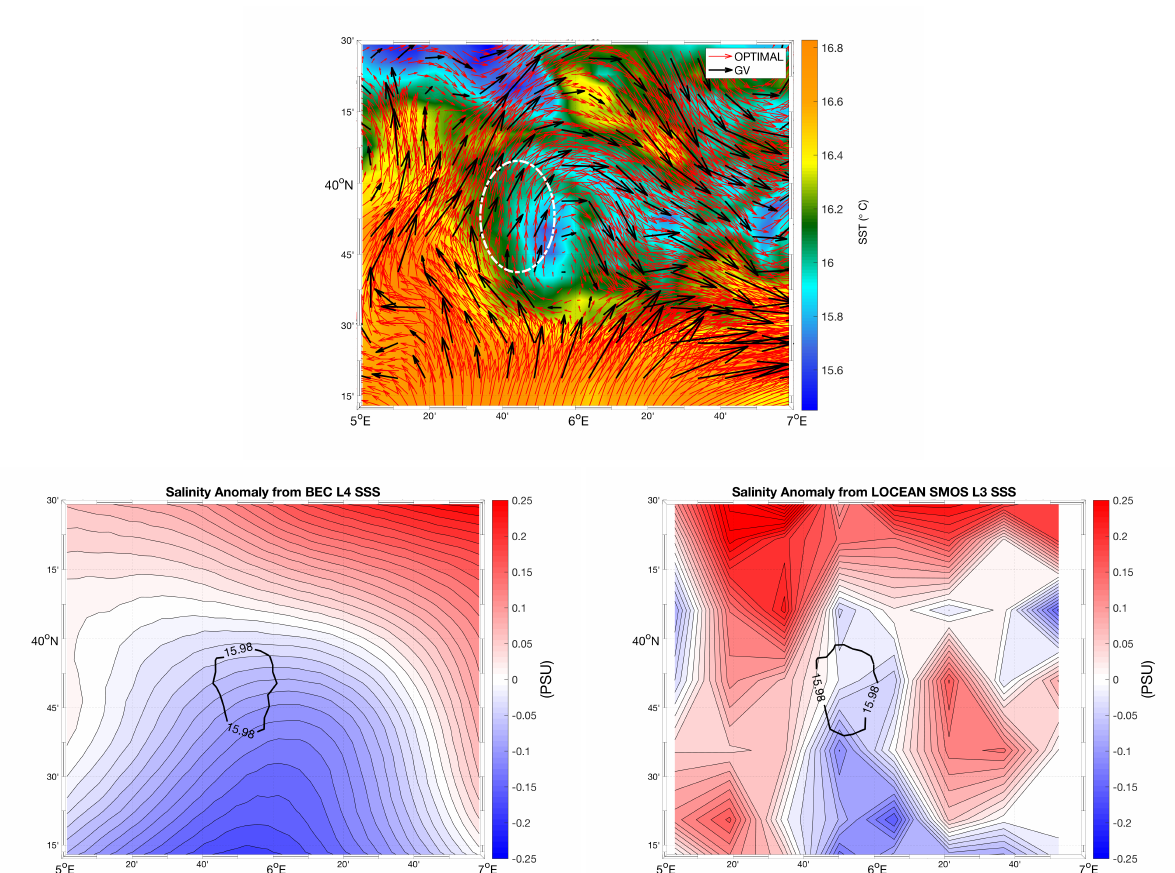
Figure 4. Top: Comparison between the Optimal currents (red arrows) and the GV (black arrows) in presence of anticyclonic circulation in the Western Mediterranean (25th of April 2016). The surface currents fields are superimposed to the SST (in colours, ◦ C); the white ellipse is referenced in Section 4.1. Bottom left: Soil moisture and ocean salinity (SMOS)-derived sea-surface salinity (SSS) salinity anomaly from Barcelona Expert Center (25th of April 2016). The black closed contour is the 15.9 ◦ C level indicating the position of the vortex. Bottom right: Same as bottom left, using the LOCEAN L3 SMOS SSS data, on the 26th of April 2016